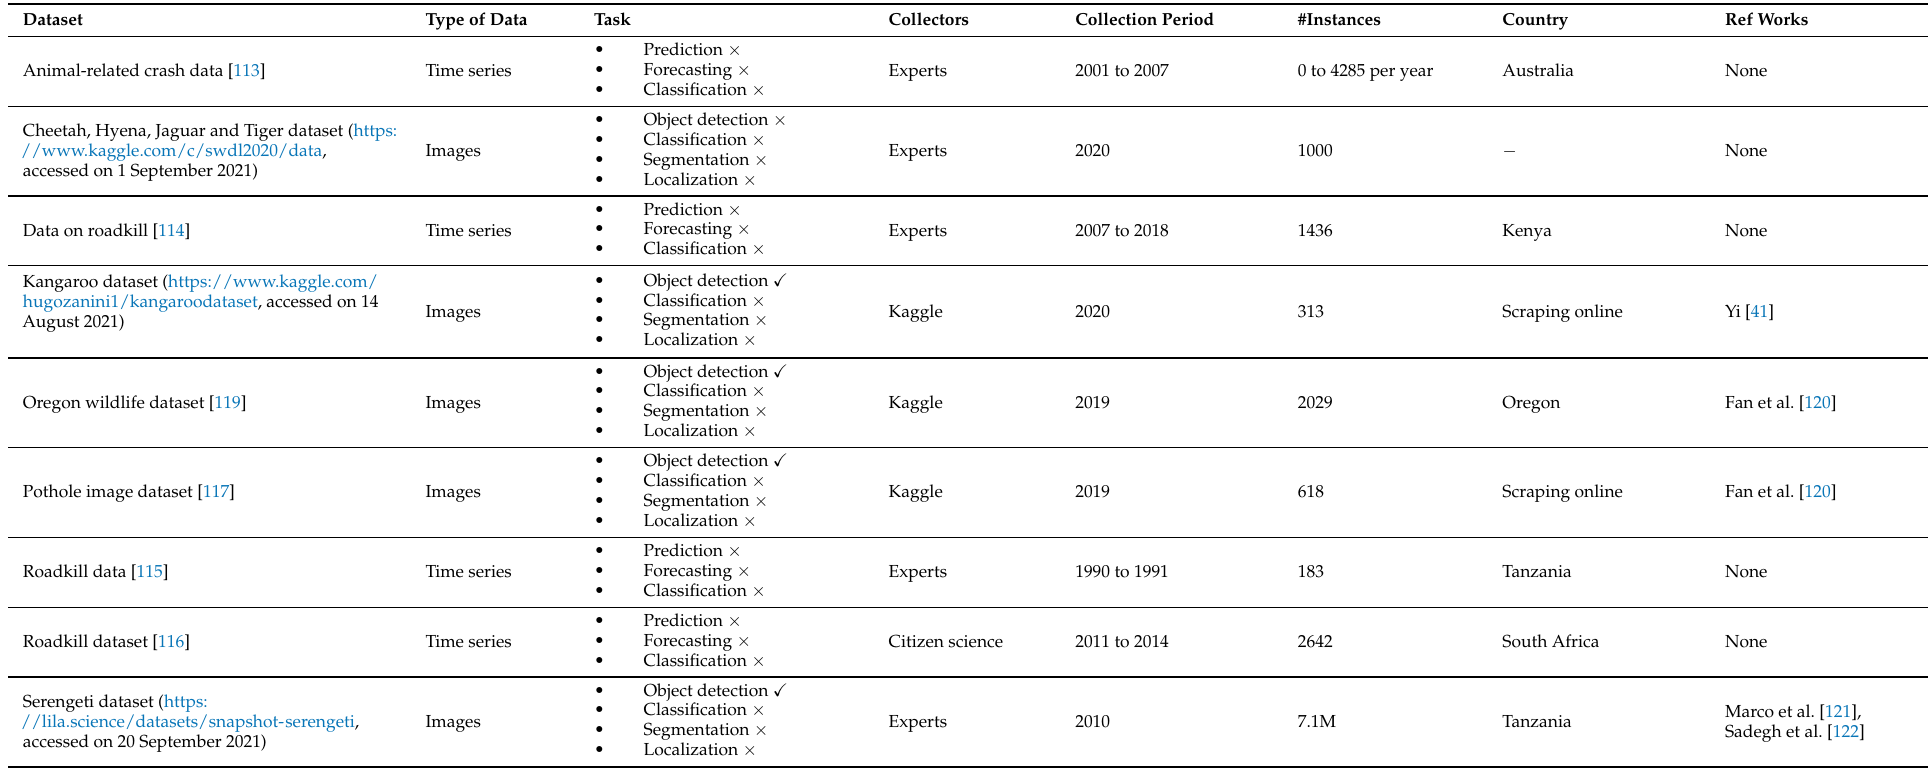
Table 8. Summary of datasets that are used in mitigating WVCs showing types of dataset, task ( (cid:88) means task is performed on data and × means a task we have proposed that can be performed on data and no work in the literature has performed the task), collectors, collection period, number of instances, and country ( − means authors did not state data collection period, instances, and